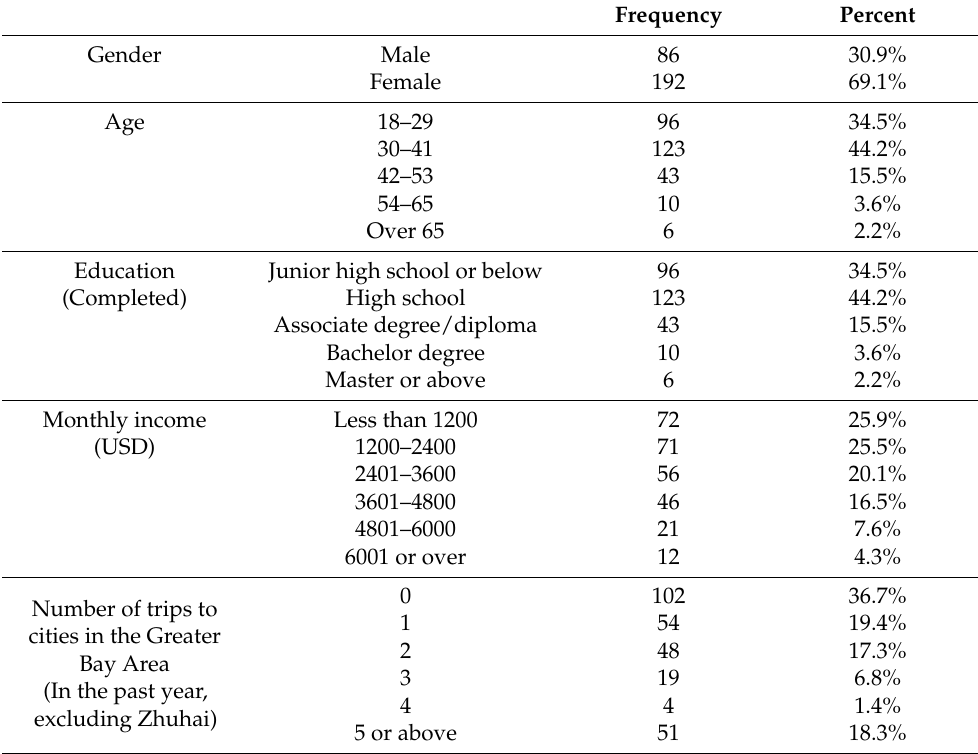
Table 2. Respondents’ background ( n = 278).